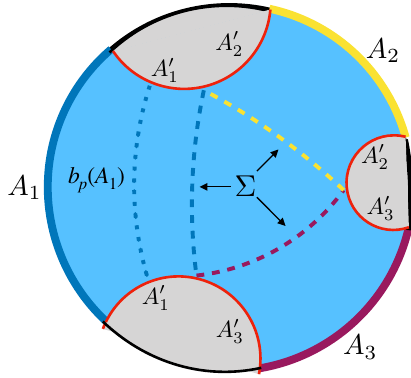
Figure 1 . The geometric construction of the bipartite and multipartite entanglement wedge cross sections illustrated for the case of three regions. The joint RT surface O := m ( A ) is shown in red. This is then partitioned into regions A 0 , and the total area of the corresponding minimal surfaces i m ( A i A 0 ) is minimized over all partitions. The minimal surfaces Σ( A i ) are shown as colored dashed i lines; their union is Σ . Also shown as a dotted line is the surface b p ( A 1 ) which is the minimal surface homologous to A 1 relative to O